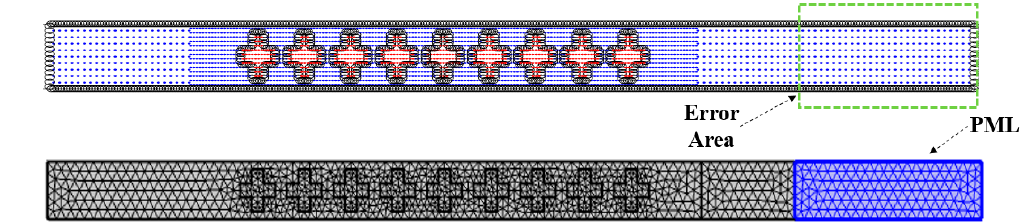
Figure 13. Node distribution with error region and element distribution with PML region for the phononic crystal with semi-infinite periodic structure in the y-direction.